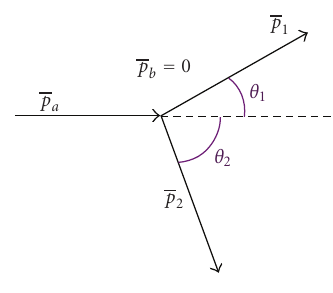
Figure 1: Scheme of two body reaction model.